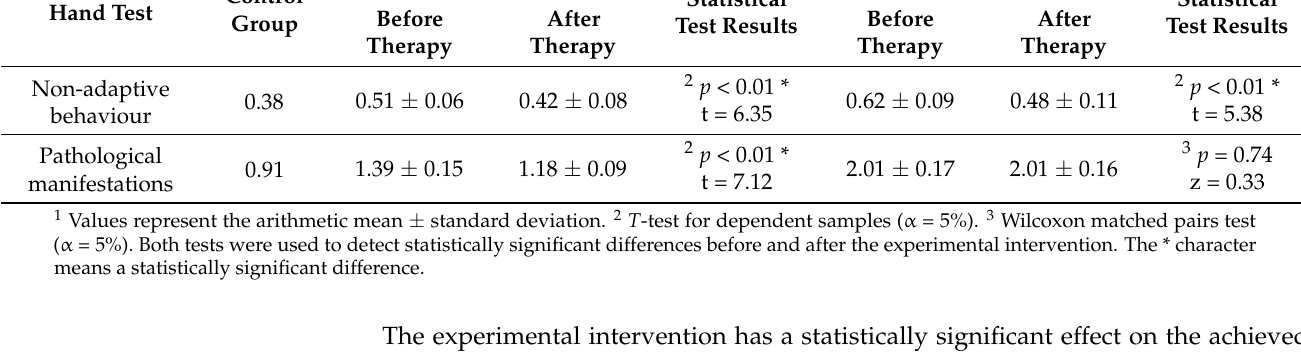
Table 2. Group averages for The Hand Test categories related to the distance from reality and the level of pathology before and after forest therapy.